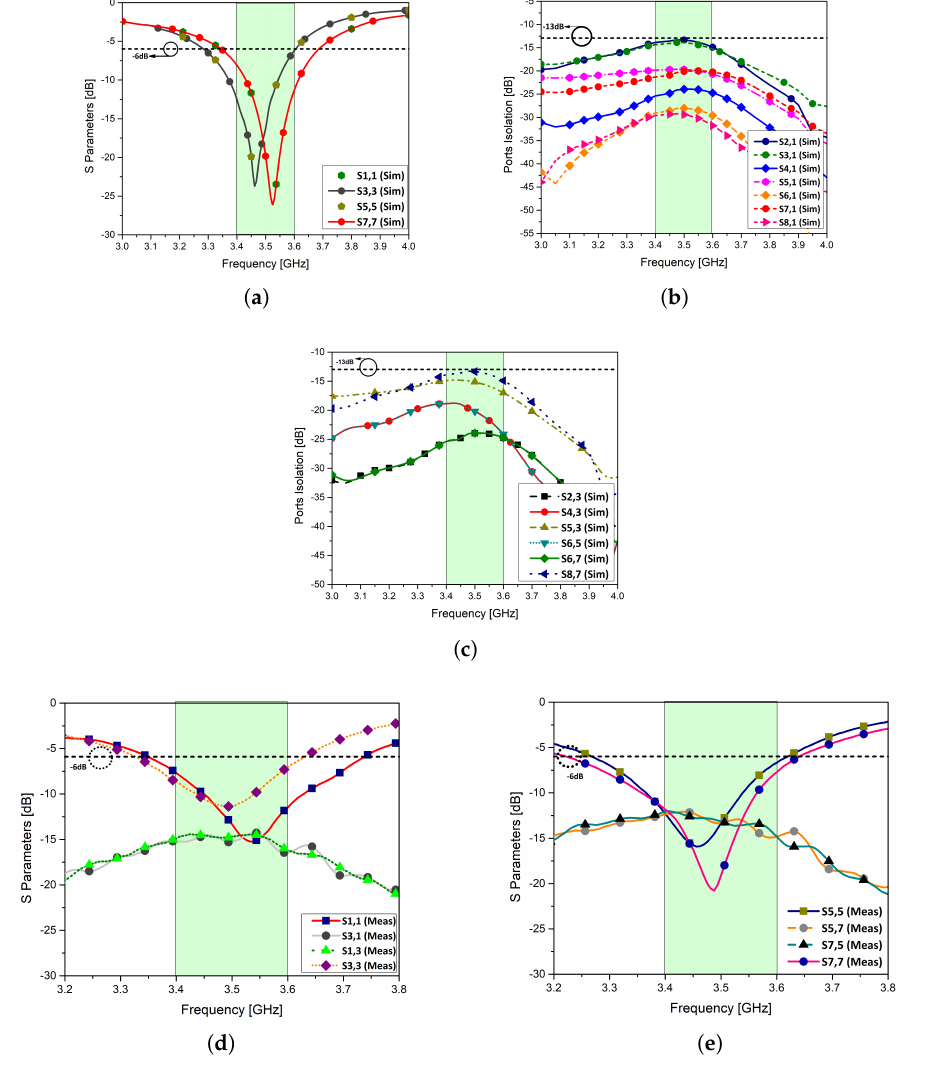
Figure 5. ( a ): Reflection coefficient of proposed MIMO configuration, ( b ): port isolation of antenna element 1, ( c ): port isolation of selected antenna elements, ( d ): measured S-parameters of antenna elements 1 and 3, ( e ): measured S-parameters of antenna elements 5 and